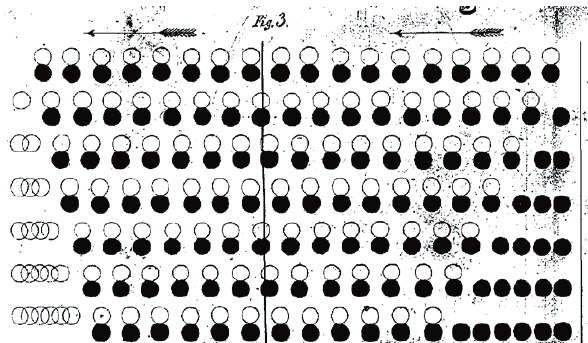
Figure 2. Hittorf´s concept and determination of the relative veloci- ties and transference numbers for the case that anions and cations have different migration velocities. Anions: black full circles; cations open circles. Cations migrate in direction of the arrows to the left, anions to the right. Details are described in the text. (From ref. [36]